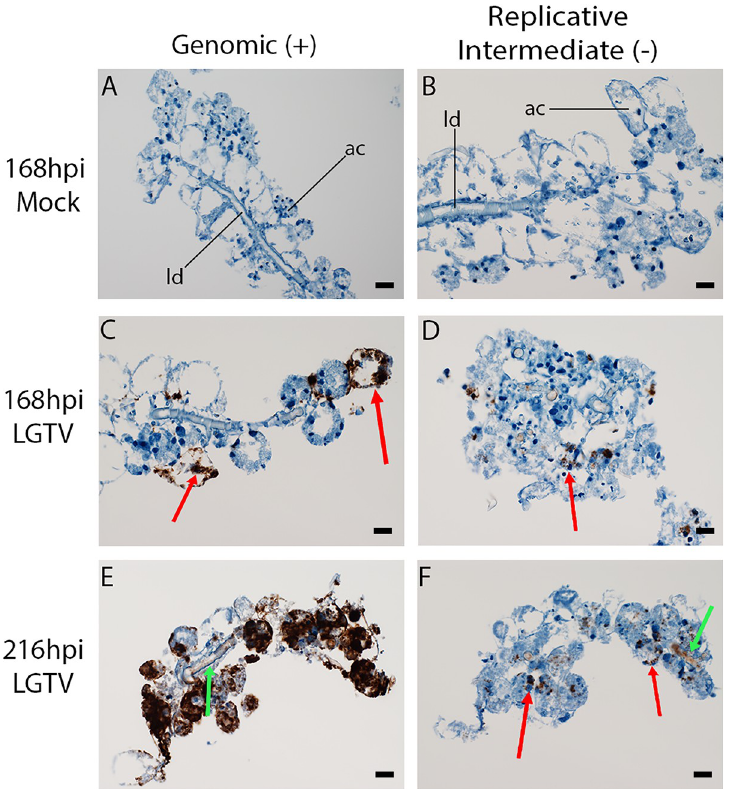
Fig 6. Strand-specific in situ hybridization of LGTV RNA in infected SG cultures from male ticks. Male Ixodes scapularis salivary gland (SG) cultures were infected with 5 x 10 5 focus-forming units of Langat virus (LGTV) and stained with RNAscope V-Langat and RNAscope V-Langat-sense probes (Advanced Cell Diagnostics, Newark, CA) to reveal the location of viral RNA. Images were taken at 40X magnification and display a single SG from a pool of 4 SG pairs per experimental group. Each SG measured approximately 1mm in length, and each granular acinus measured roughly 40–50 microns in diameter. Red arrows indicate localizations of LGTV RNA in acini and green arrows indicate LGTV RNA on cells lining the lobular duct. ld–lobular duct, ac–acinus. Sections in panels A, C, and E were treated with an “antisense” probe to reveal location of plus-sense strand LGTV RNA in brown. Sections in panels B, D, and F were treated with the “sense” probe to reveal location of minus-sense strand LGTV RNA, an obligatory marker for viral replication. Mock-infected samples at 168 hours post infection (hpi) and also 216 hpi (not shown) exhibited no reaction with either probe. Scale bars are representative of 40